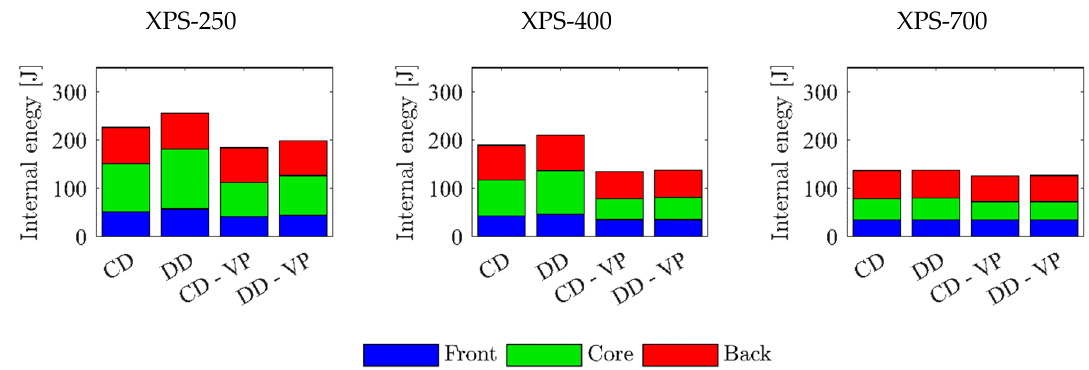
Figure 21. Distribution of internal energy in numerical simulations of tests with 10 bar firing pressure.